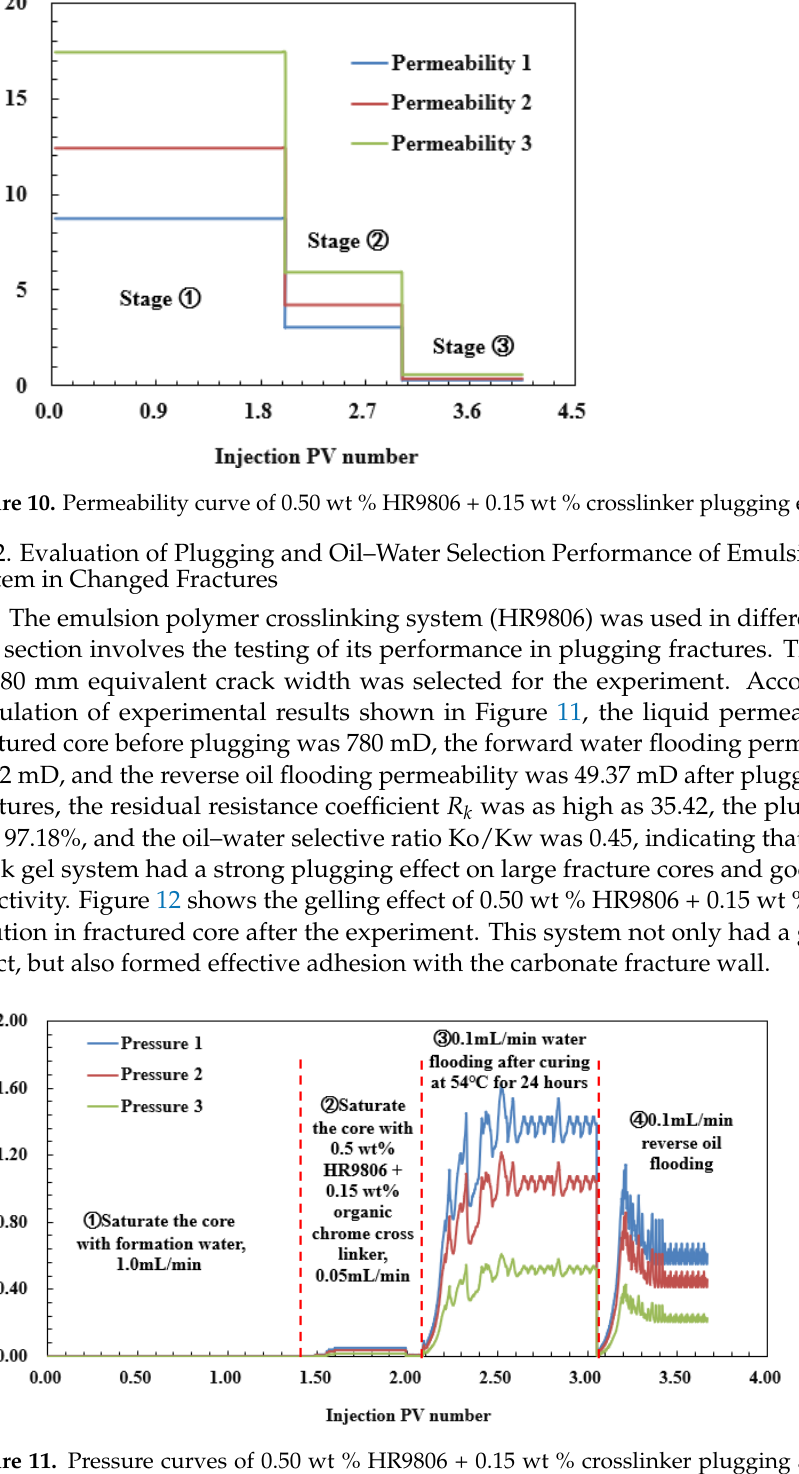
Figure 9. Pressure curve of 0.50 wt % HR9806 + 0.15 wt % crosslinker plugging experiment.